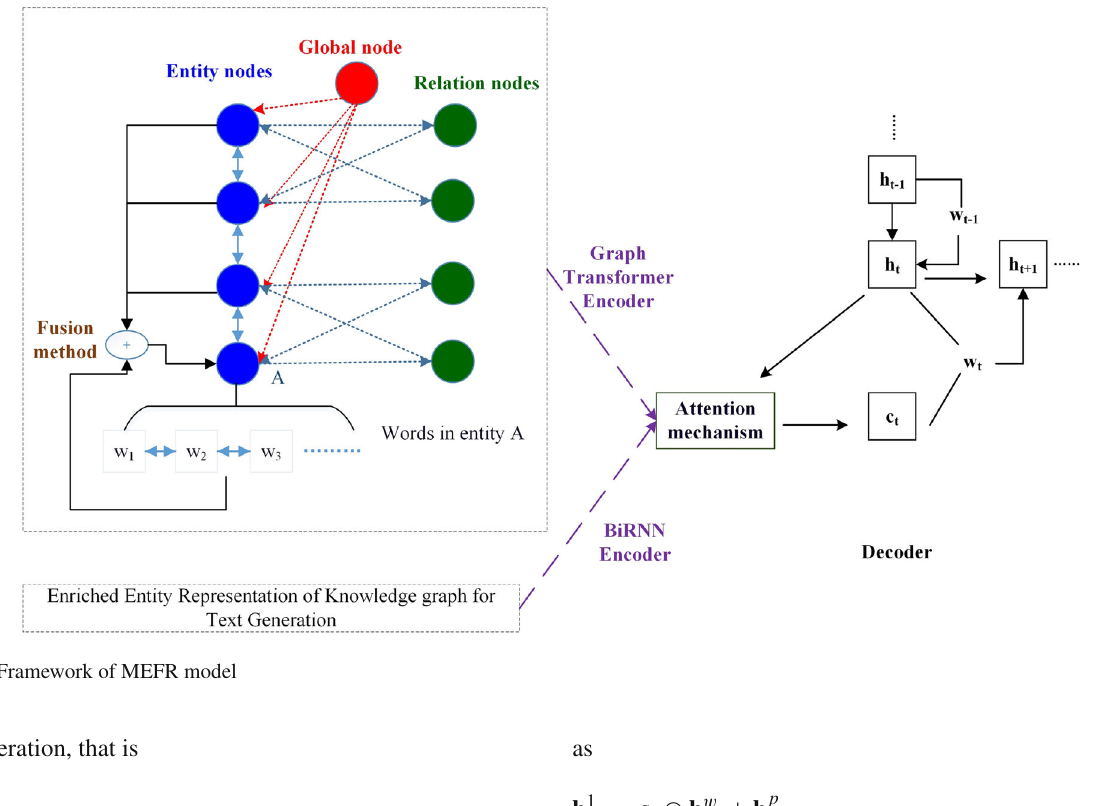
Fig. 1 Framework of MEFR